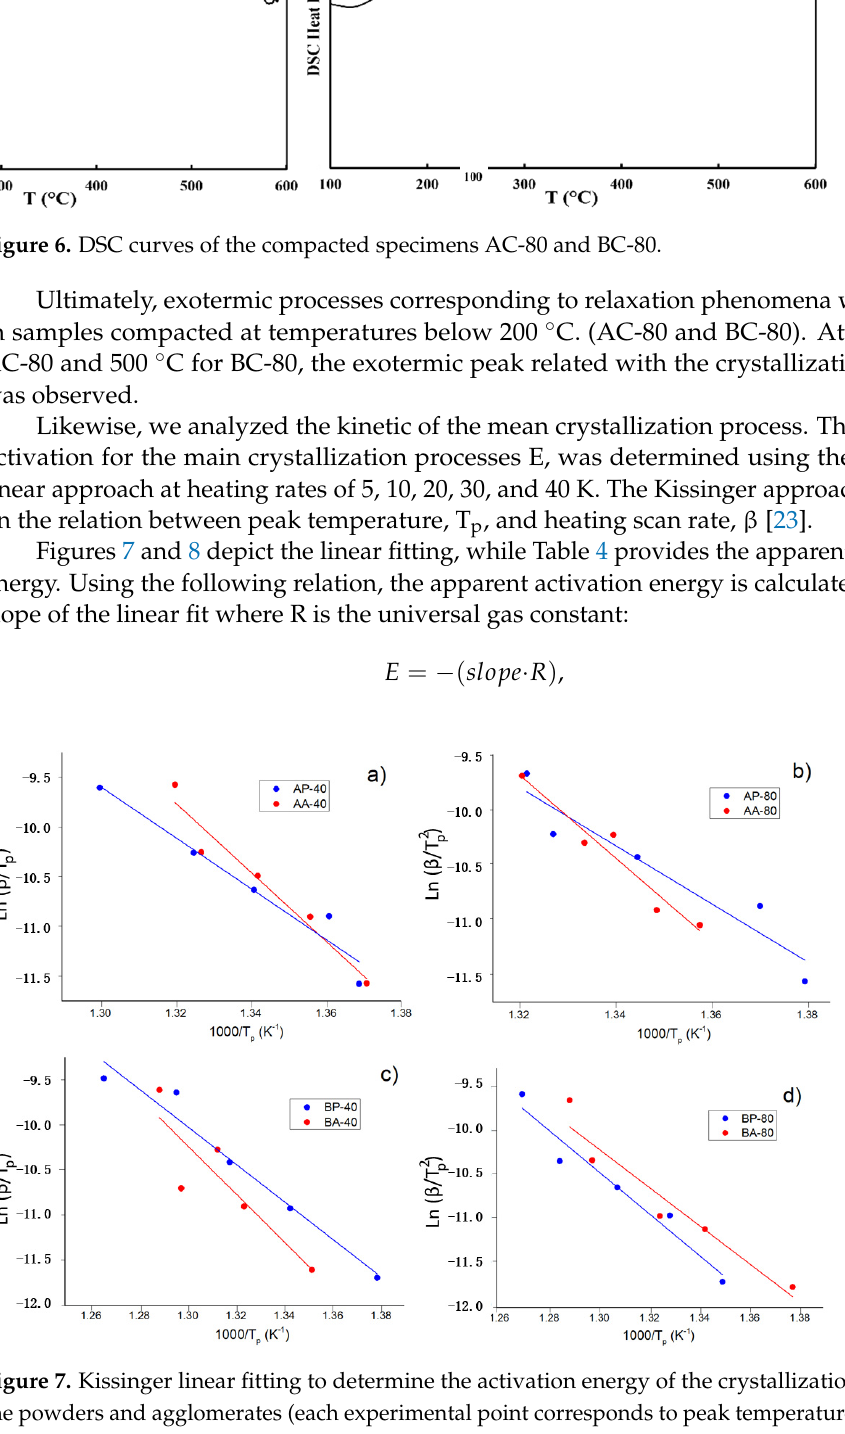
Figure 5. DSC curves collected in pairs for samples (AP-40 and AA-40), (AP-80 and AA- 80), (BP-40 and BA-40), and (BP-80 and BA-80) to observe the behavior of powders and agglomerated particles after the same milling duration.